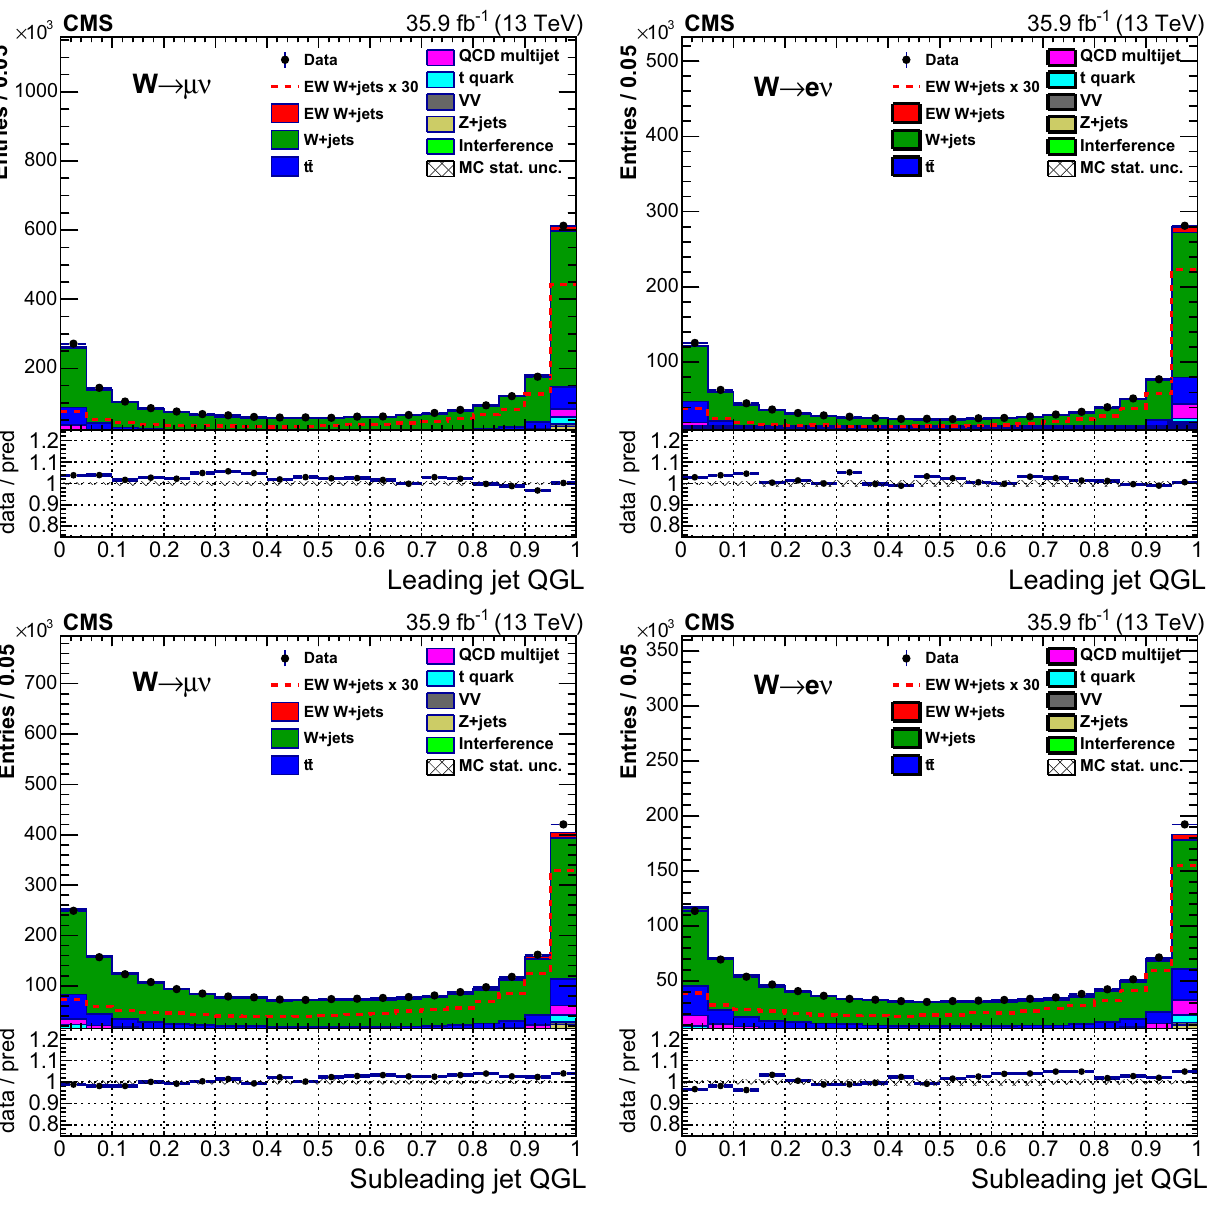
Fig. 7 The QGL output for the leading (upper) and subleading (lower) quark jet candidates in the preselected muon (left) and electron (right) samples